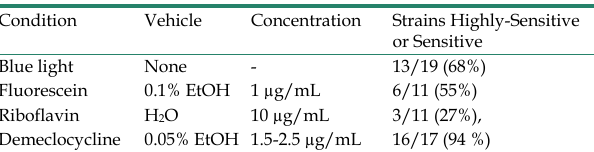
Table 2. Summary of C. acnes killing with blue light alone vs